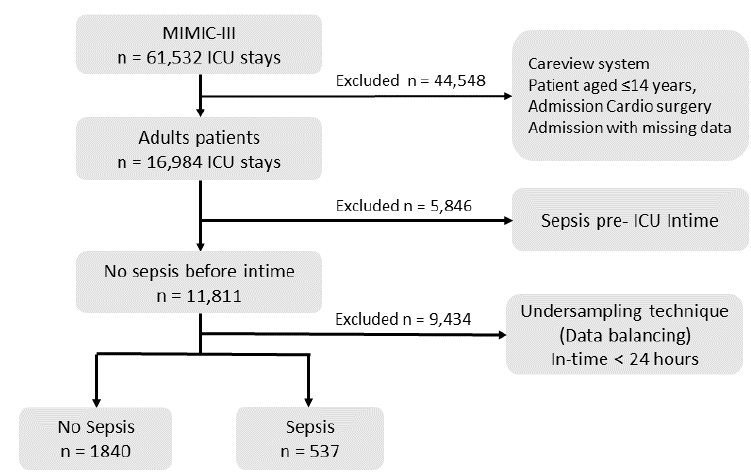
Figure 2. Representation of the labeling method.